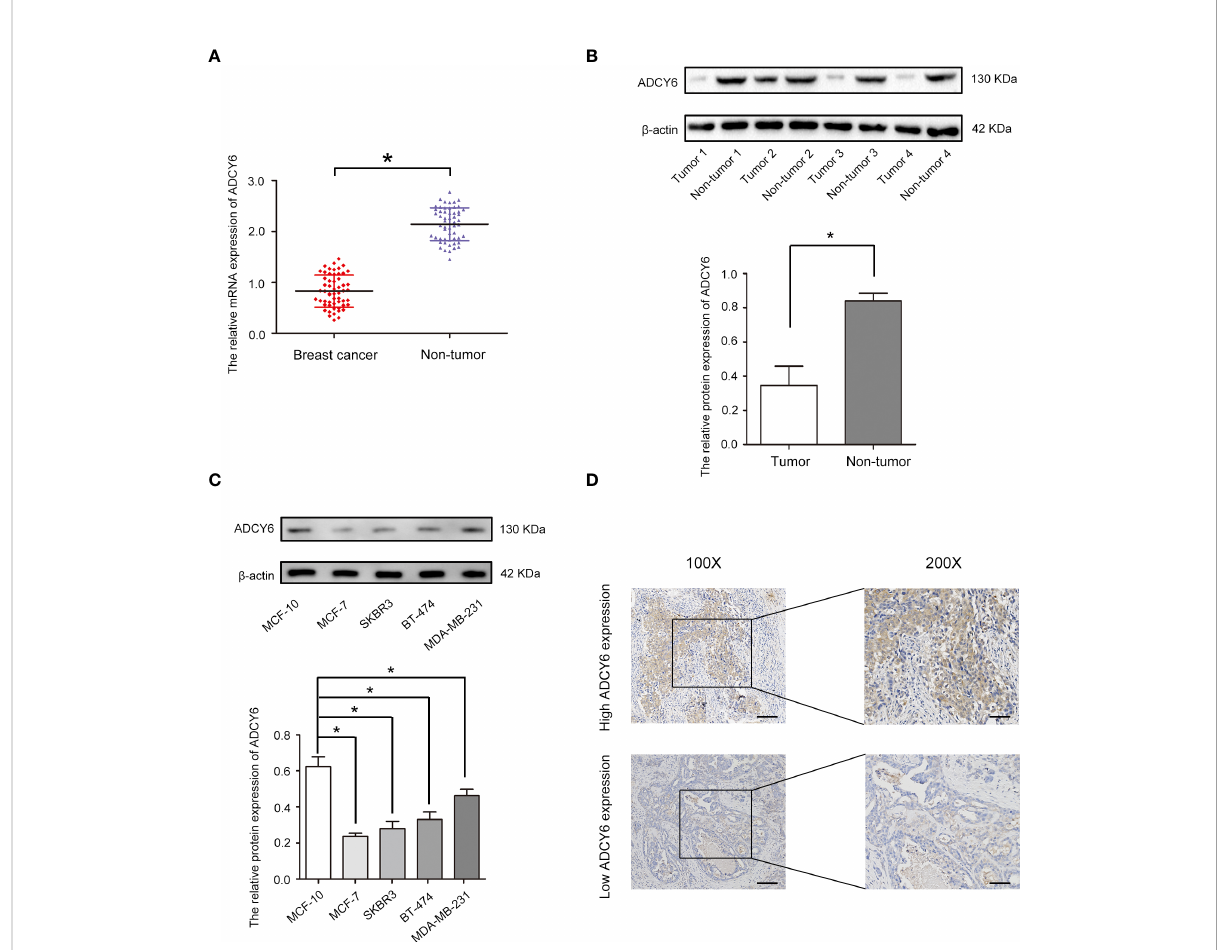
FIGURE 1 ADCY6 expression is decreased in breast cancer samples and cell lines. (A) The mRNA expression of ADCY6 in breast cancer samples. N = 56. *p < 0.05 versus the adjacent normal tissues. (B) The protein expression of ADCY6 in breast cancer samples. *p < 0.05 versus the adjacent normal tissues. (C) The protein expression of ADCY6 in breast cancer cell lines. *p < 0.05 versus MCF-10 cells. (D) ADCY6 staining was performed in representative breast cancer samples. Scale bars, 100